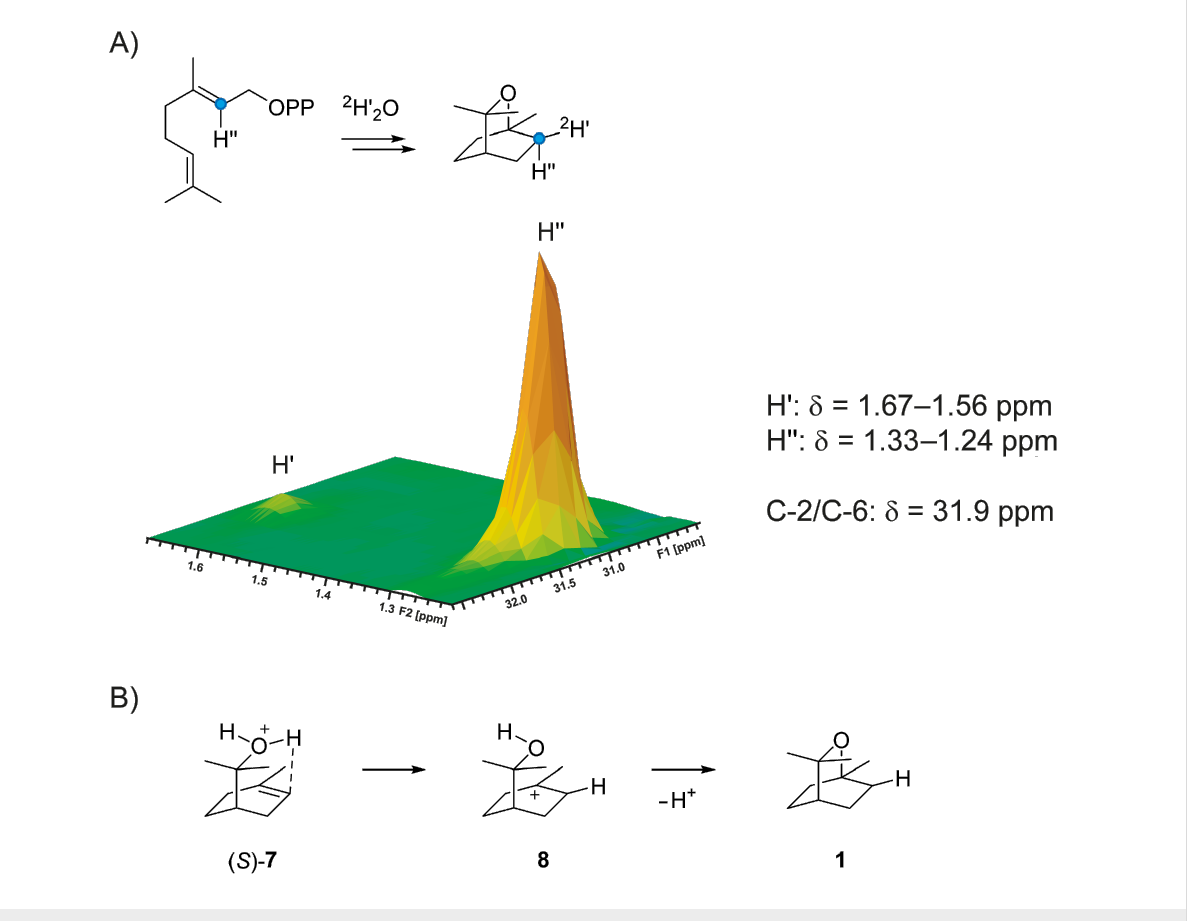
Figure 3: A) Partial HSQC spectrum showing the region of crosspeaks of C-2 with its directly connected hydrogens H’ and H’’ for compound (2- 13 C,2- 2 H)- 1 obtained by enzymatic conversion of (2- 13 C)GPP in deuterium oxide. Deuterium was specifically incorporated into H’ position. The indi- cated chemical shift data are for unlabelled 1 (for full data cf. Table S1, Supporting Information File 1). Blue circles point to 13 C-labelled carbons. B) Intramolecular proton transfer from the protonated hydroxy function in ( S )- 7 to